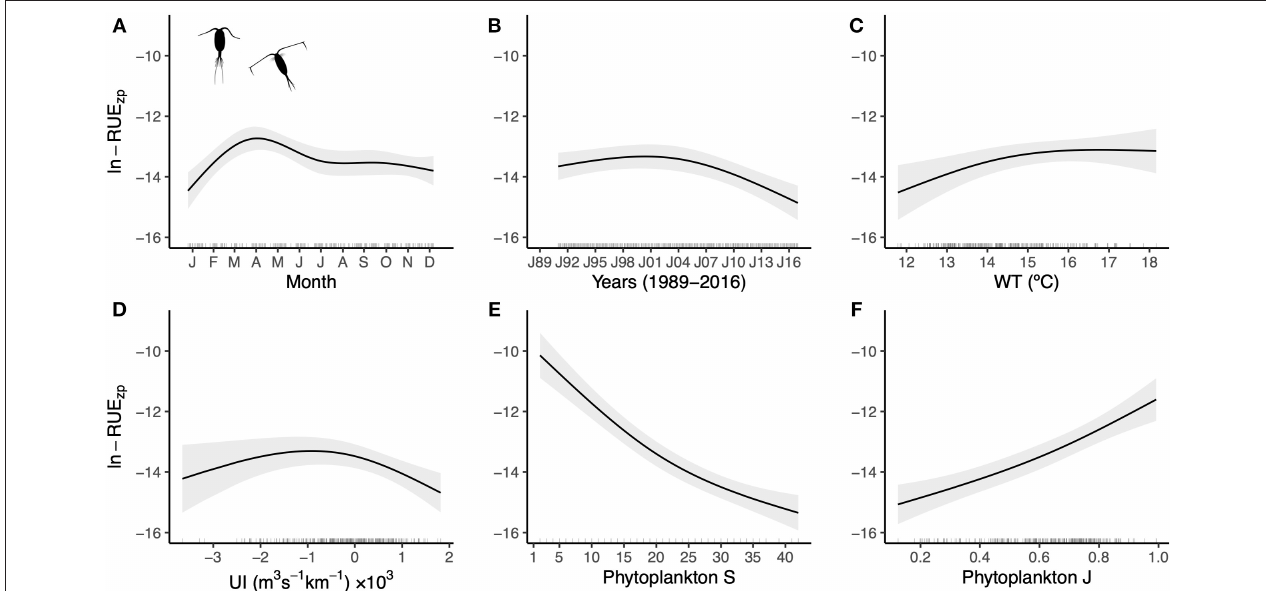
FIGURE 3 | Partial-effects plots from the RUE zp GLS model depicted in Equation (2). Shown are the seasonal (A) and long-term (B) changes in RUE zp , and the relationships with water temperature (C) , upwelling index (D) , phytoplankton richness (E) , and phytoplankton evenness (F) . Bands indicate 95% confidence intervals, and the rugs along the x-axes display the distribution of the data. See ANOVA table in Supplementary Table 4 , and model selection of variance covariates in Supplementary Table 5 . Silhouettes were obtained from